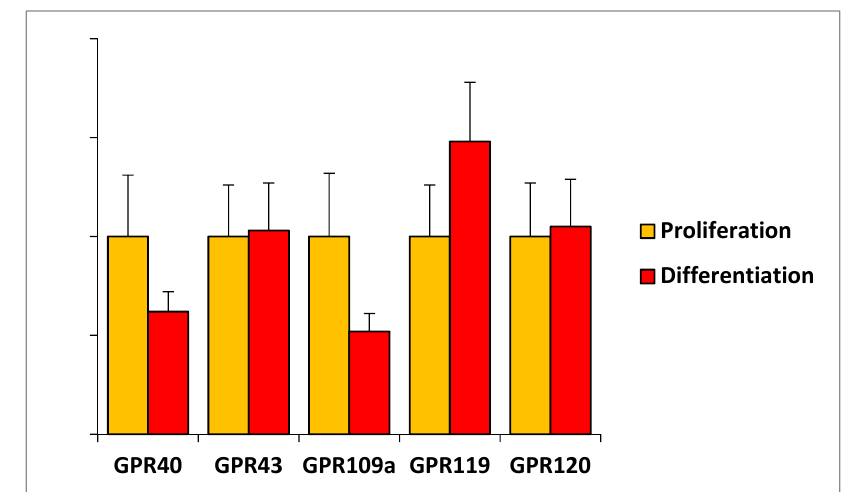
Figure 8. Expression of G-protein-coupled receptors in C2C12 myoblasts. Relative mRNA expression levels of several indicated GPCRs in C2C12 myoblasts in proliferation or in di ff erentiation ( n = 8 for each group). Relative mRNA levels obtained are expressed in percent of the corresponding control value in proliferation. Results are expressed as means ±